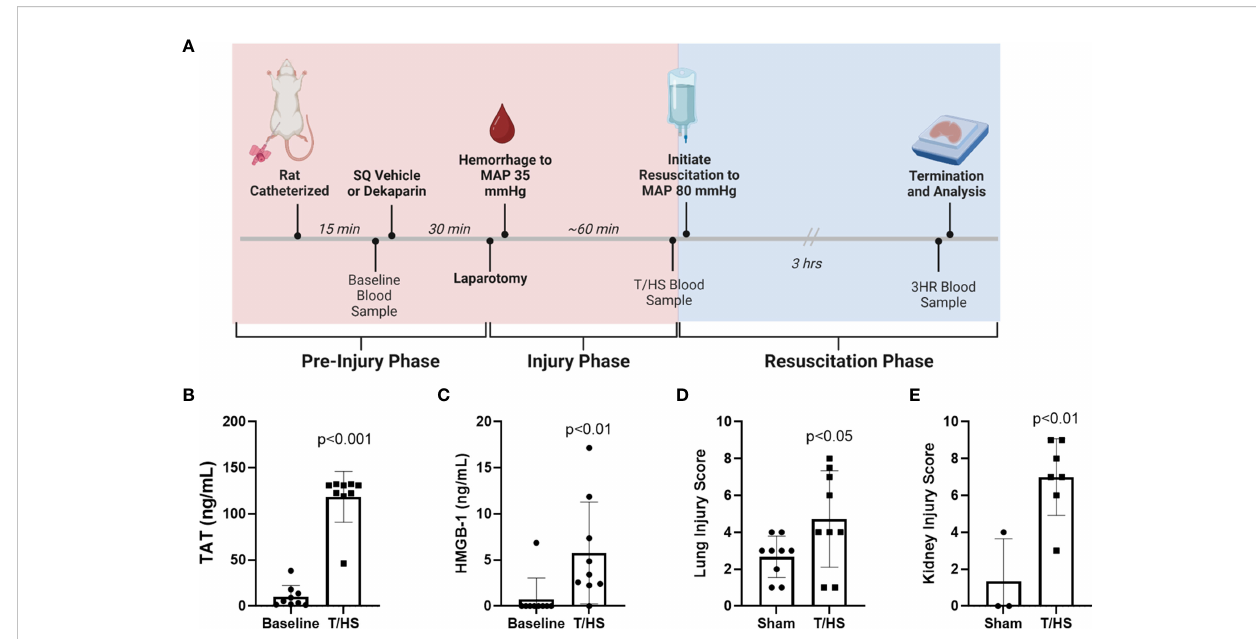
FIGURE 2 Rat model of trauma and hemorrhagic shock (T/HS) induces systemic markers of thromboin fl ammation and multiple organ injury. (A) Experimental schema including treatment administration, induction of T/HS through laparotomy and controlled hemorrhage, resuscitation, and sampling timeline. (B) Thrombin-antithrombin (TAT) complex and (C) high mobility group box-1 (HMGB-1) levels were measured after T/HS by enzyme-linked immunosorbent assay (N=9 per group). Data were compared using paired t tests. (D) Lungs (N=9 per group) and (E) kidneys (N=3 sham and N=7 T/ HS) were collected 3 hours after resuscitation (3HR) with LR and stained with hematoxylin and eosin and degree of organ injury scored by a blinded pathologist. Data presented as mean with standard deviation. SQ, subcutaneous; MAP, mean arterial pressure; LR, Lactated